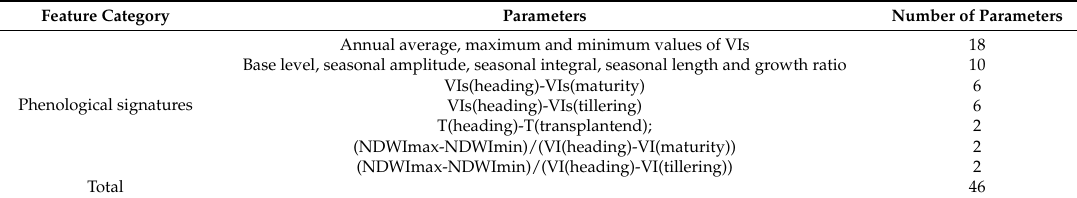
Table 2. List of phenological signatures manually established in this